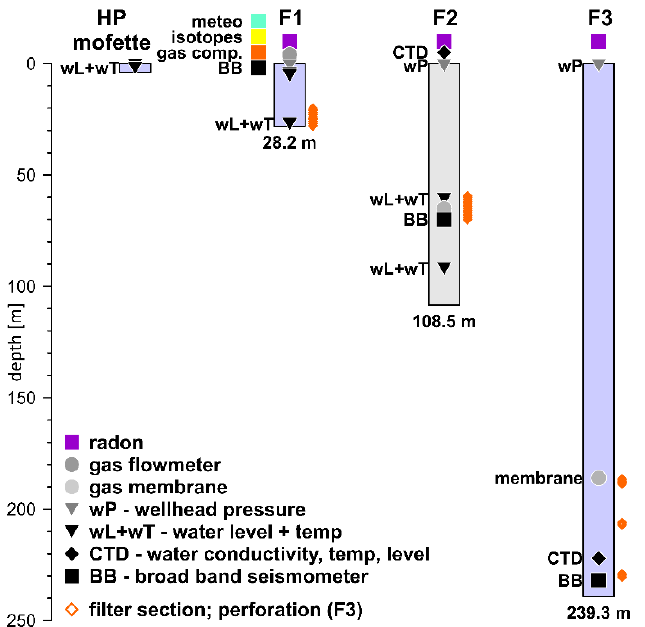
Figure 2. Principle sketch of the fluid and seismic monitoring setup at the Hartoušov mofette field. While the instrumentation of F1 and F2 is in place, instrumentation of F3 is planned in the near future. The horizontal distance is not to scale.